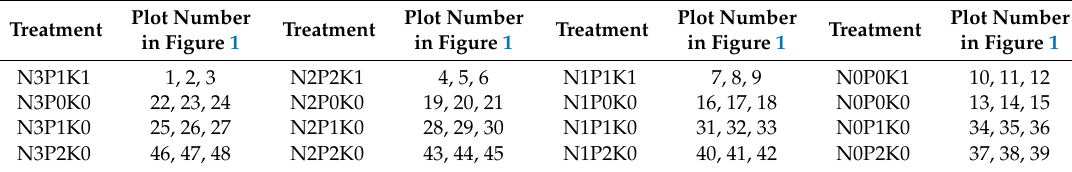
Figure 1. The arrangement of the fertilizer level experiment (aerial photography on 4 April 2019). Table 1. The treatments of N, P, and K.